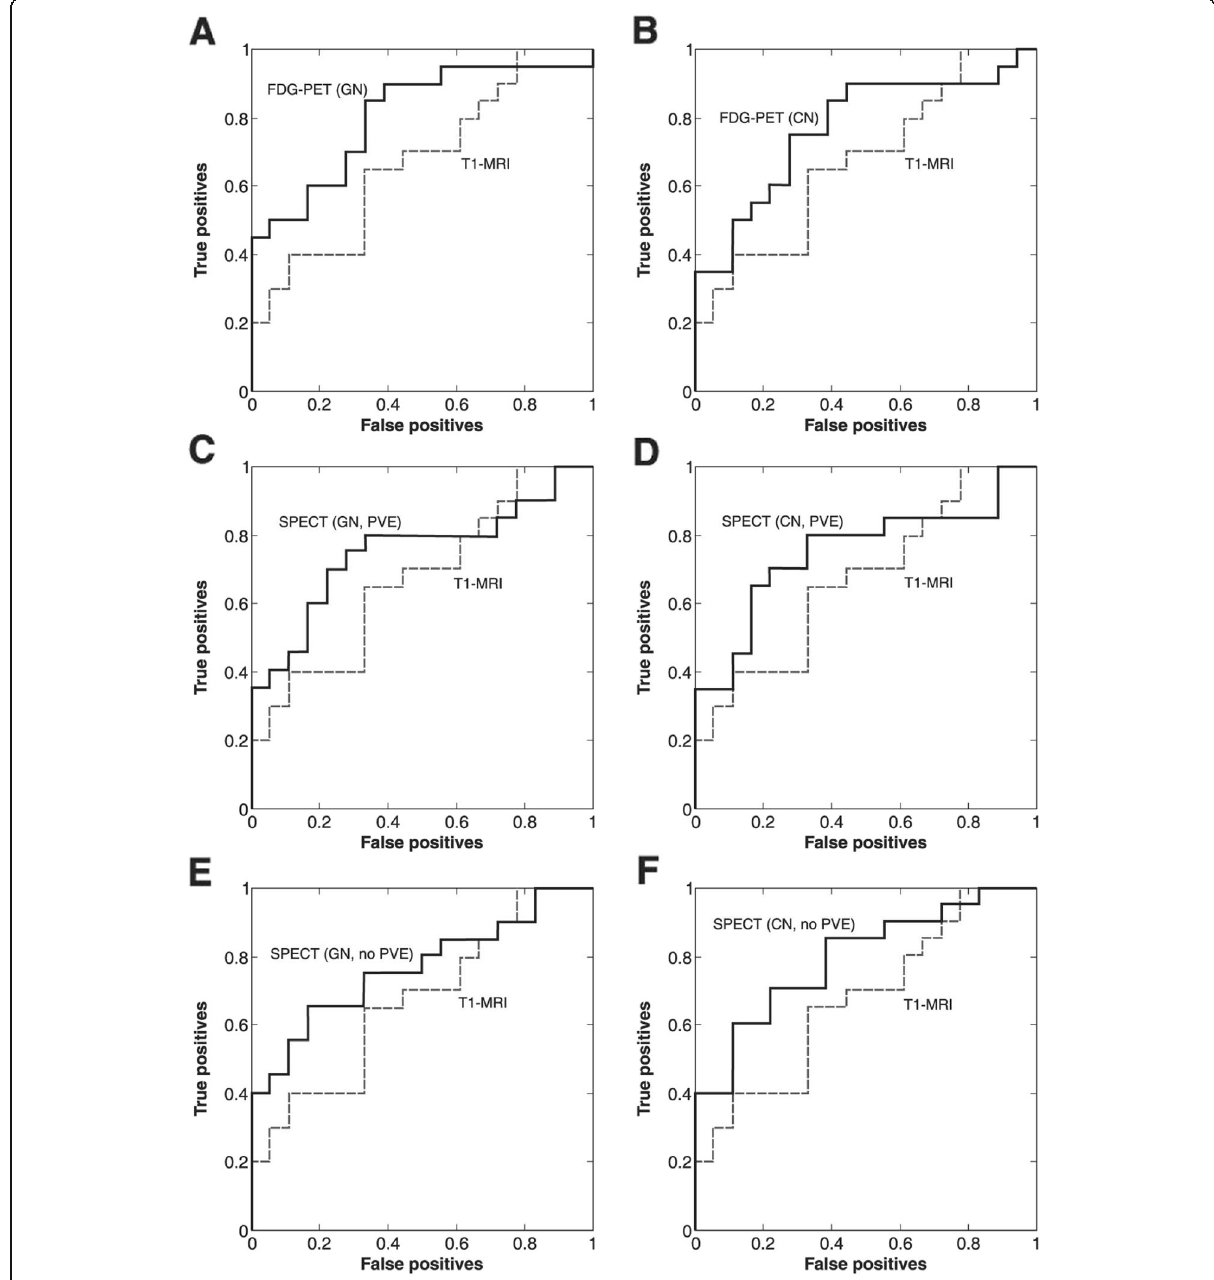
Fig. 5 Receiver operating characteristic curves of classifications using a combination of imaging